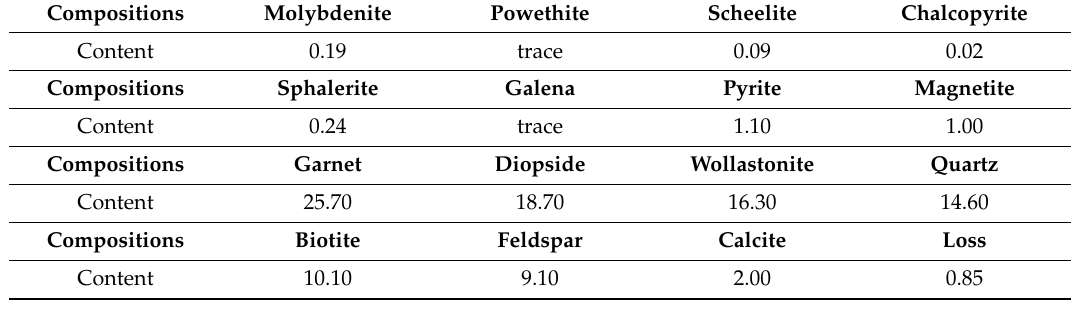
Table 1. The elemental composition of the actual Mo ore (wt %).